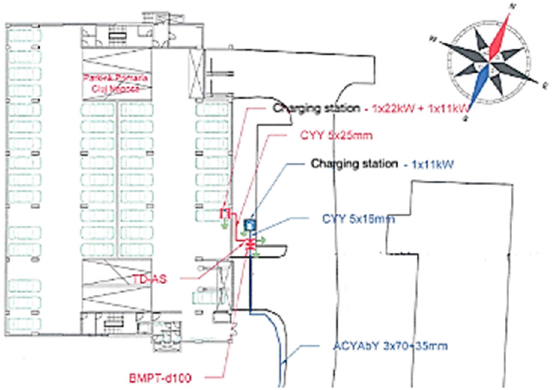
Figure 4. Supply plan for the EV charging station in Motilor Street [13].